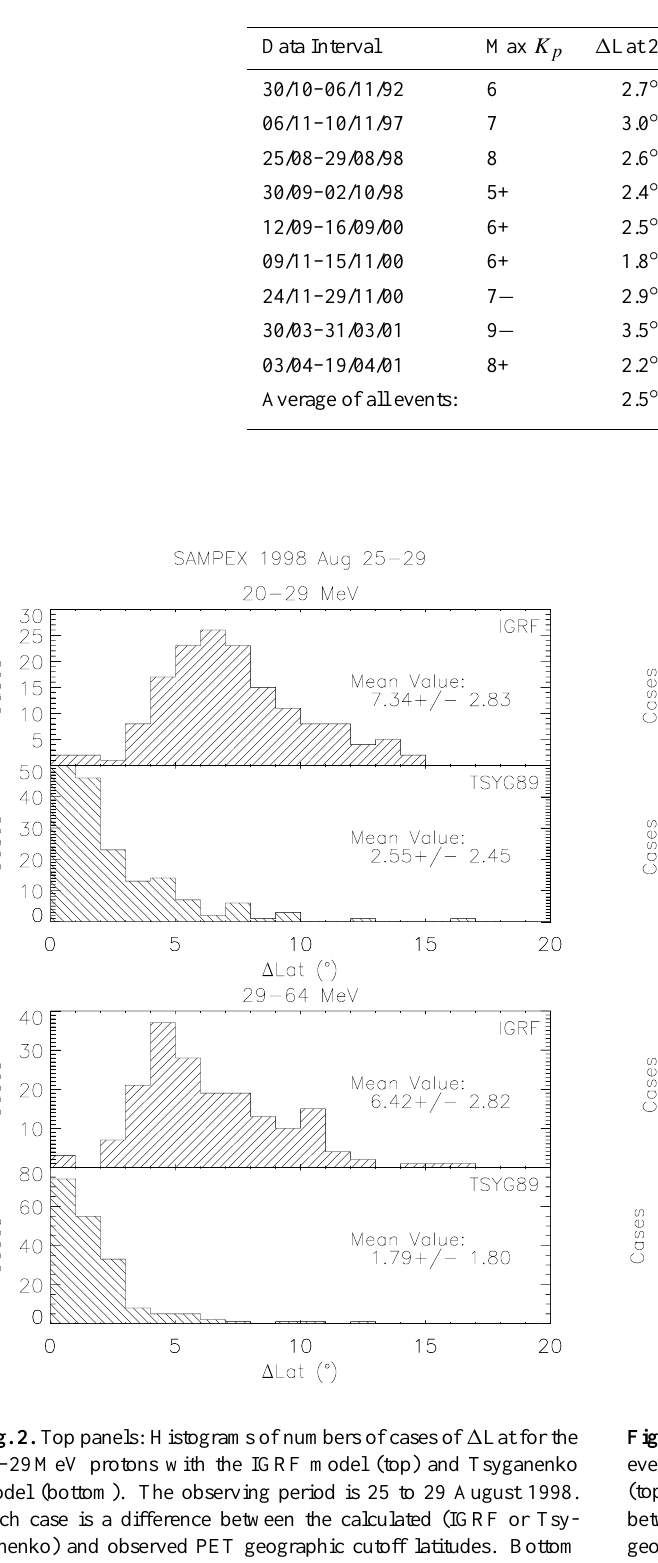
Table 2. Average latitudinal differences 1 Lat for the Tsyganenko field in the nine analyzed SEP events